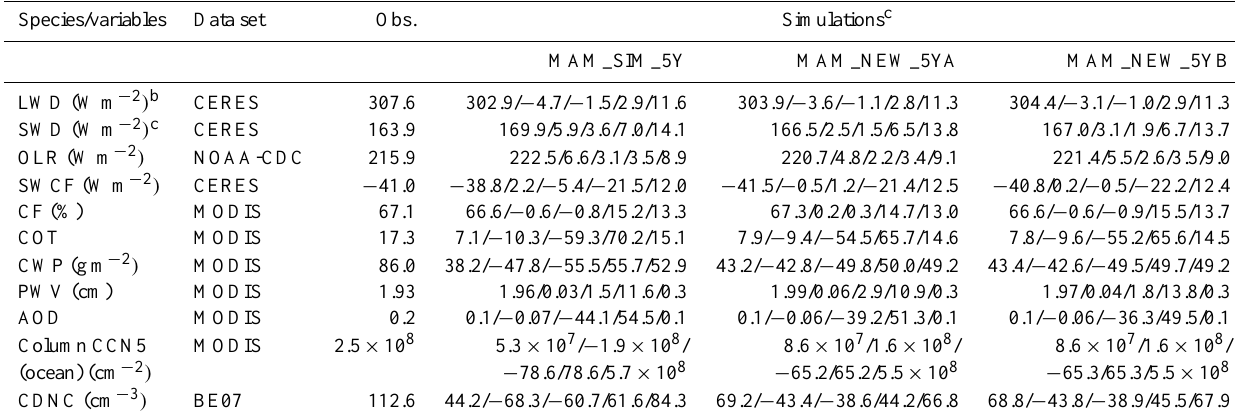
Table 5. Statistical performance of radiative/cloud prediction (average of the 2001–2005 simulations). Species/variables Data set